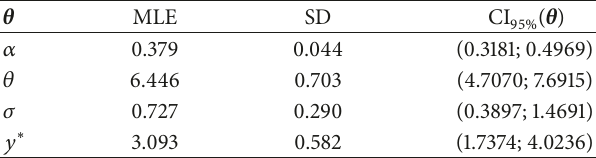
Table 4: MLEs, standard deviations, and 95 % confidence intervals for 𝛼 , 𝜃 , 𝜎 , and 𝑦 ∗ related to the EW